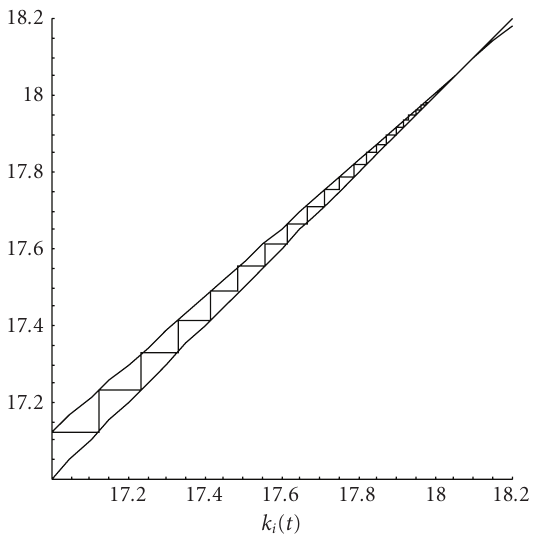
Figure 4.1. The convergence to the equilibrium